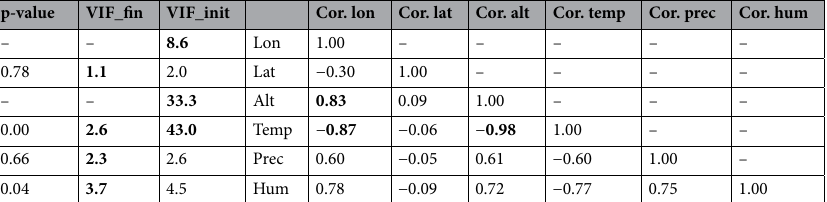
Table 4. The VIF values and correlation coefficients of the second-stage input features. VIF_init and VIF_fin show the initial and final VIF values, respectively. Cor. shows the correlation coefficients of the features. The p values of the parameters selected by the VIF process are shown. Significant p values are displayed in bold fonts (<